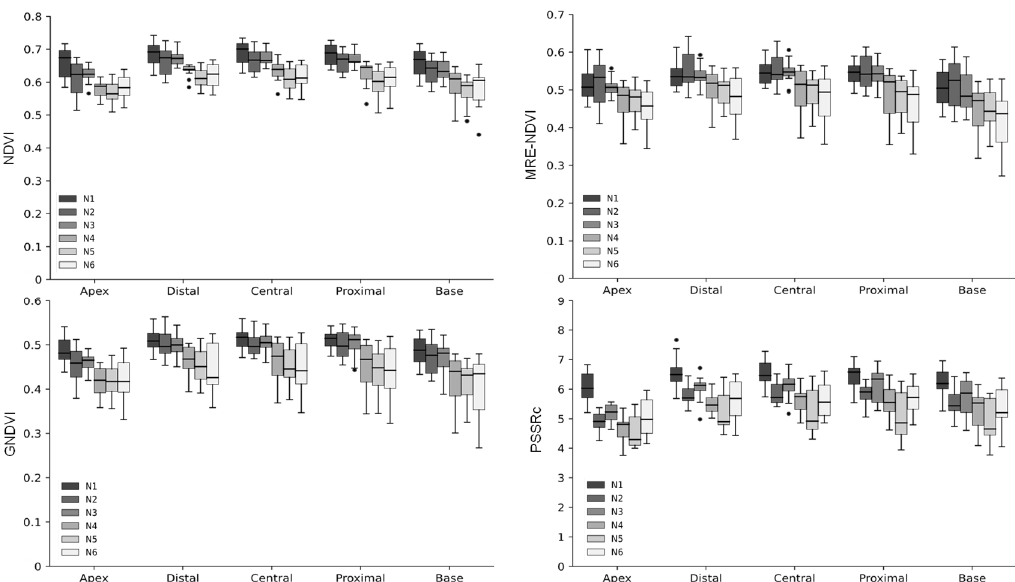
Figure 5. Variation of vegetation indices by the nitrogen levels. Vegetation indices were calculated with the spectral data of the base region in each organ. In the box plots, the bottom and top of the box describe the 25th and 75th percentiles, the band near the middle of the box is the 50th percentile (the median); the ends of the whiskers represent the minimum and maximum of the data. The black circle dots indicate outliers.